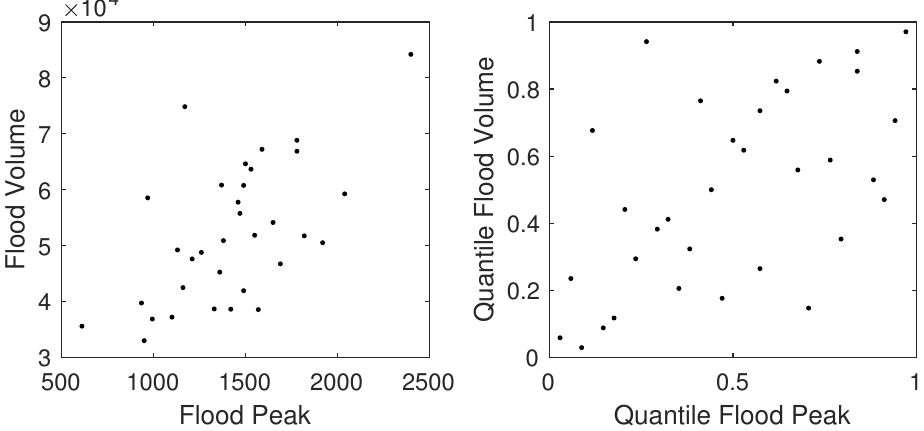
Figure 3. Left Panel: 33 flood peak and flood volume observations from the Ashuapmushuan basin in Quebec, Canada. Right Panel: The same data, but rank-transformed to the copula domain [ 0,1 ] 2